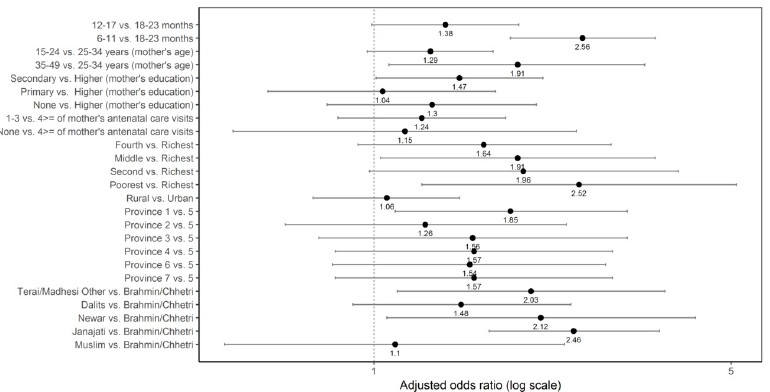
Fig 10. Odds ratio plot with 95% confidence intervals for not consuming legumes and nuts among Nepalese children aged 6 to 23 months.